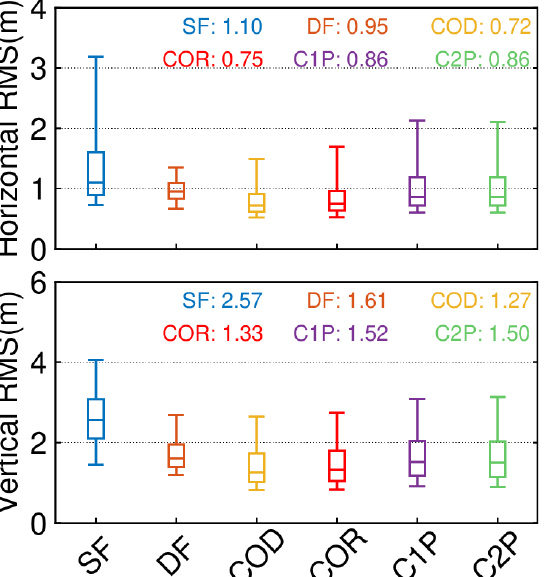
Figure 16. Boxplot of positioning accuracy of 145 tracking stations for different ionospheric